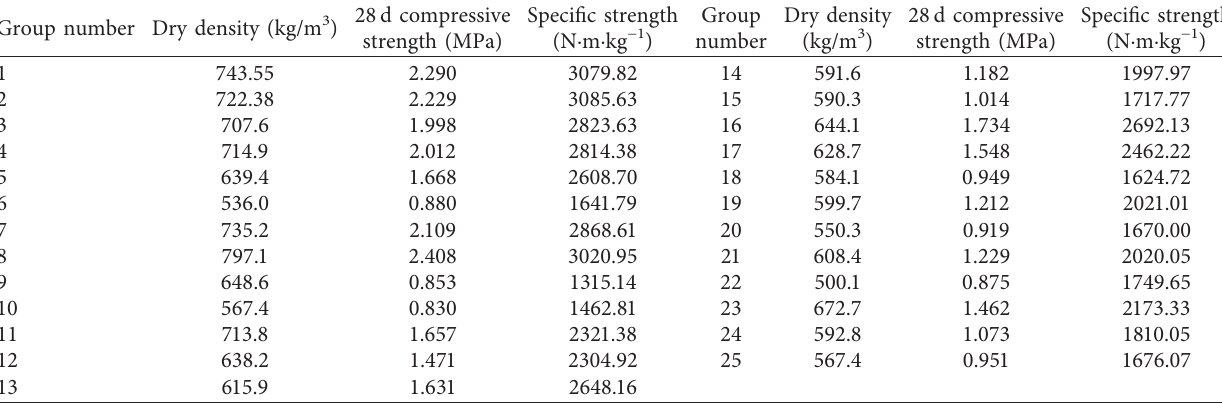
Table 8: Orthogonal test results of ordinary foam concrete.